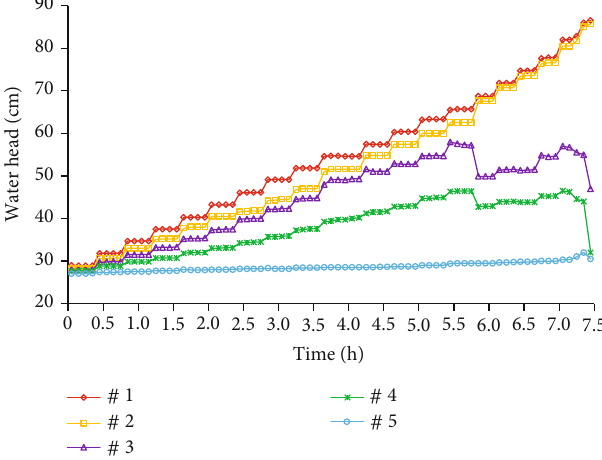
Figure 11: Process curve of water head of di ff erent piezometers located in soil numbered